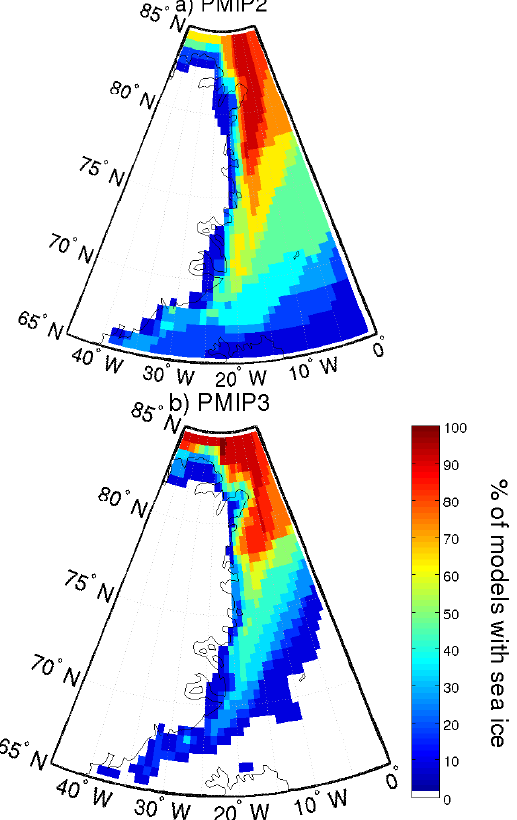
Fig. 7. Percent of models with sea ice north-east of Greenland in the month of minimum sea-ice extent for (a) the PMIP2 and (b) the PMIP3